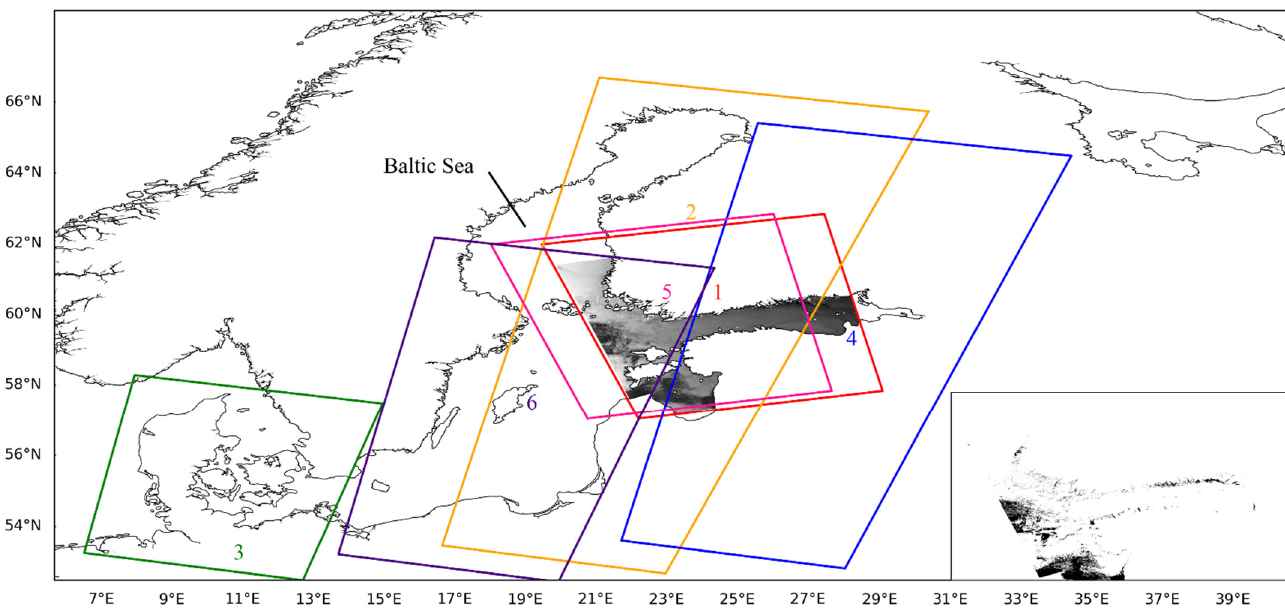
Figure 1. Overview of the research area. Numbers 1 through 6 show the coverage of the images used; and the artificially marked dark spots in image 1 are shown in the lower right corner.